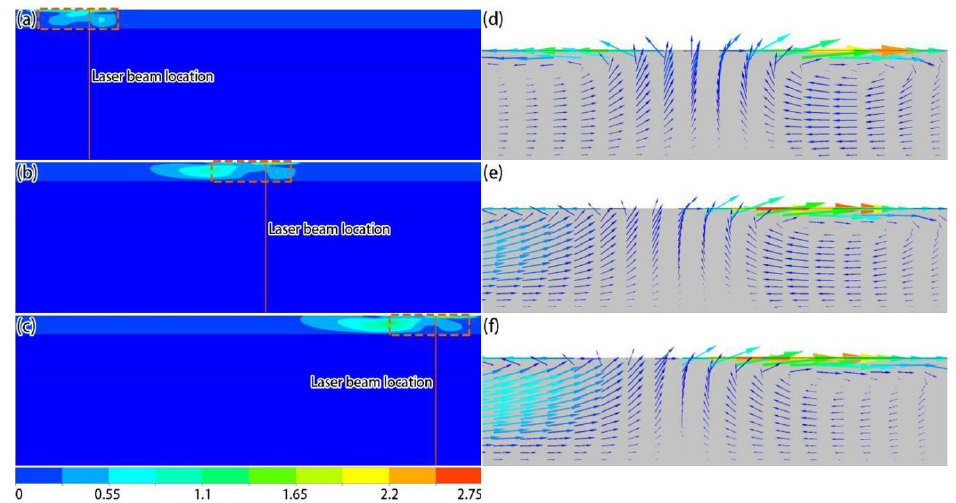
Figure 8. Simulation results of velocity magnitude ( a – c ) and local velocity ( d – f ) distributions in the middle section at different times: ( a , d ) 6 × 10 −5 s; ( b , e ) 4.5 × 10 −4 s; ( c , f ) 8.4 × 10 −4 s (unit: m/s).